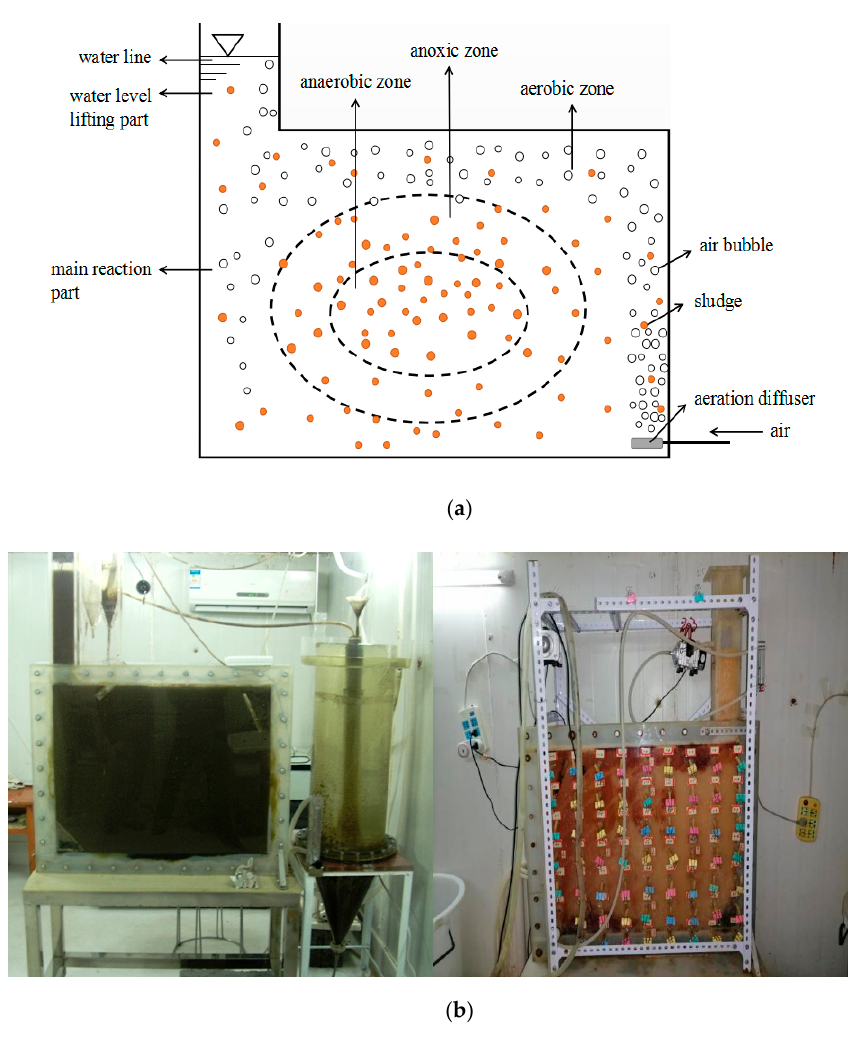
Figure 1. ( a ) Schematic diagram of the micro-pressure swirl reactor (MPSR) under ideal conditions, ( b ) the photo of MPSR actual operation. ( b ) the photo of MPSR actual